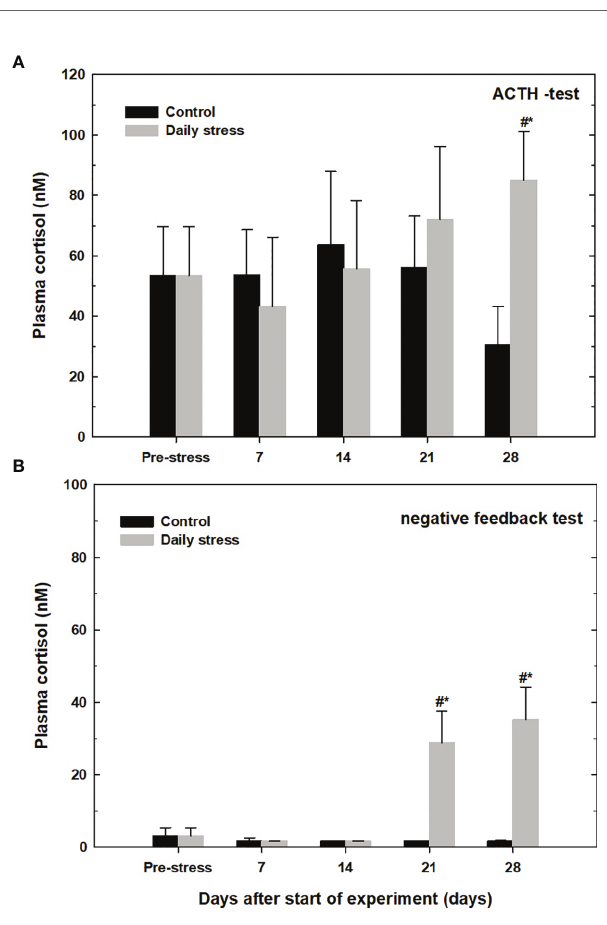
FIGURE 6 | (A) The body weight (mean ± SD, n=18) in the control group ( fi lled circles) and daily stress group ( fi lled triangles) in lump fi sh during 28 day trial. (B) The overall speci fi c growth rate (%) at the end of experiment (from day 0-28) in the control group (black bars) and daily stress group (grey bars) (n=18). # indicates signi fi cant difference between groups at the same sampling day at 95% con fi dence level, * indicates signi fi cant difference from the pre-stress level at 95% con fi dence level.